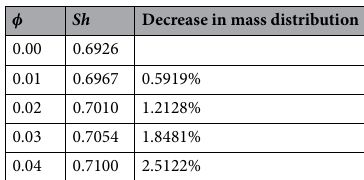
Table 5. Variation in the rate of mass transfer grease-based MoS 2